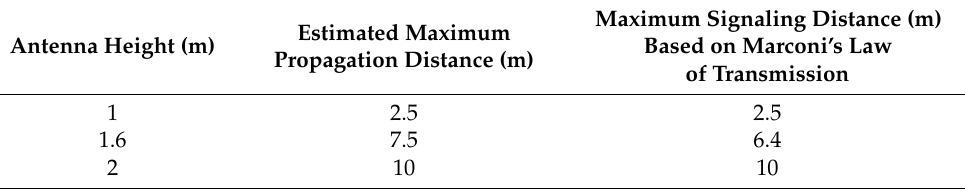
Table 2. Comparison between our estimated maximum propagation distance and the maximum signaling distance based on Marconi’s law of